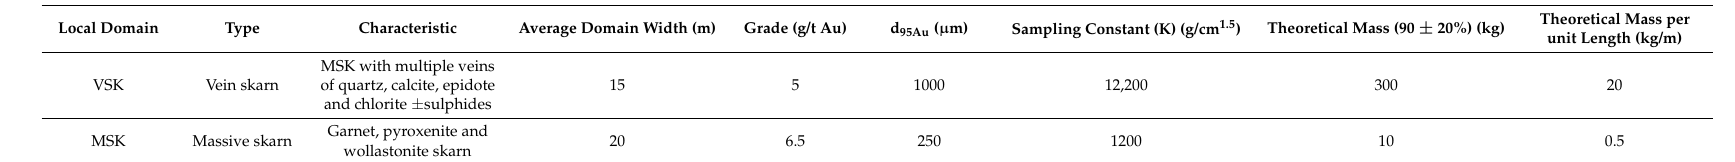
Table 10. Example of sampling characteristics for massive skarn mineralisation across local